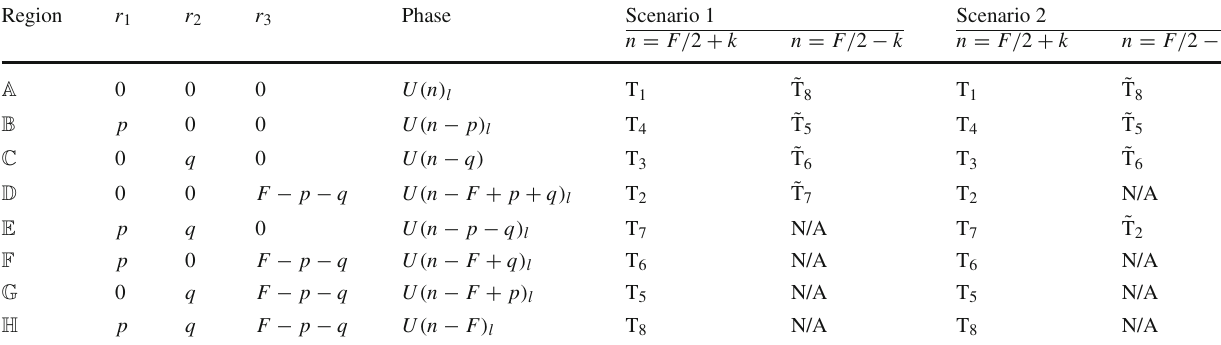
Table 1 Phases of the bosonic theory with q ≤ p ≤ F − p − q ≤ F < n